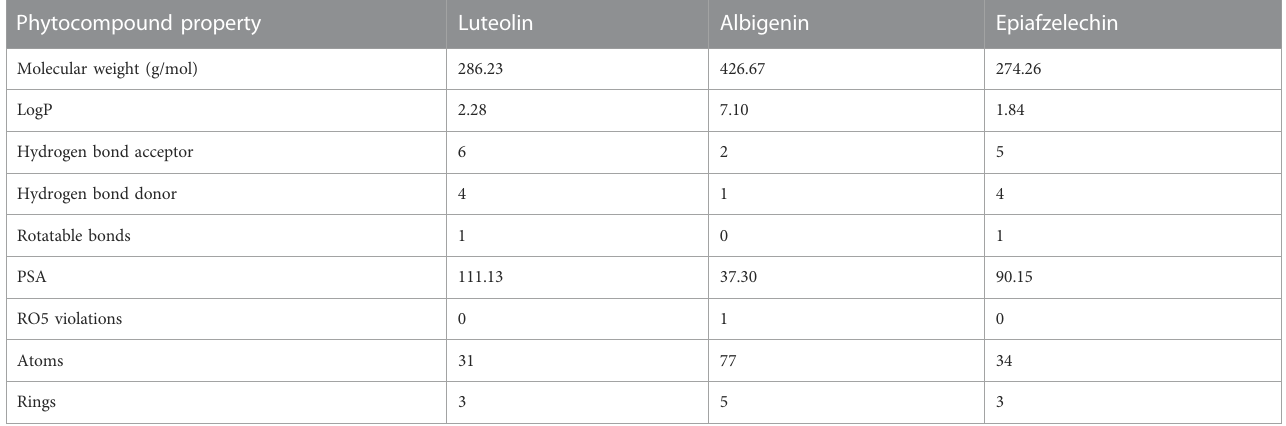
TABLE 2 Drug properties of selected phytocompounds and standard drug clavazin. Phytocompound